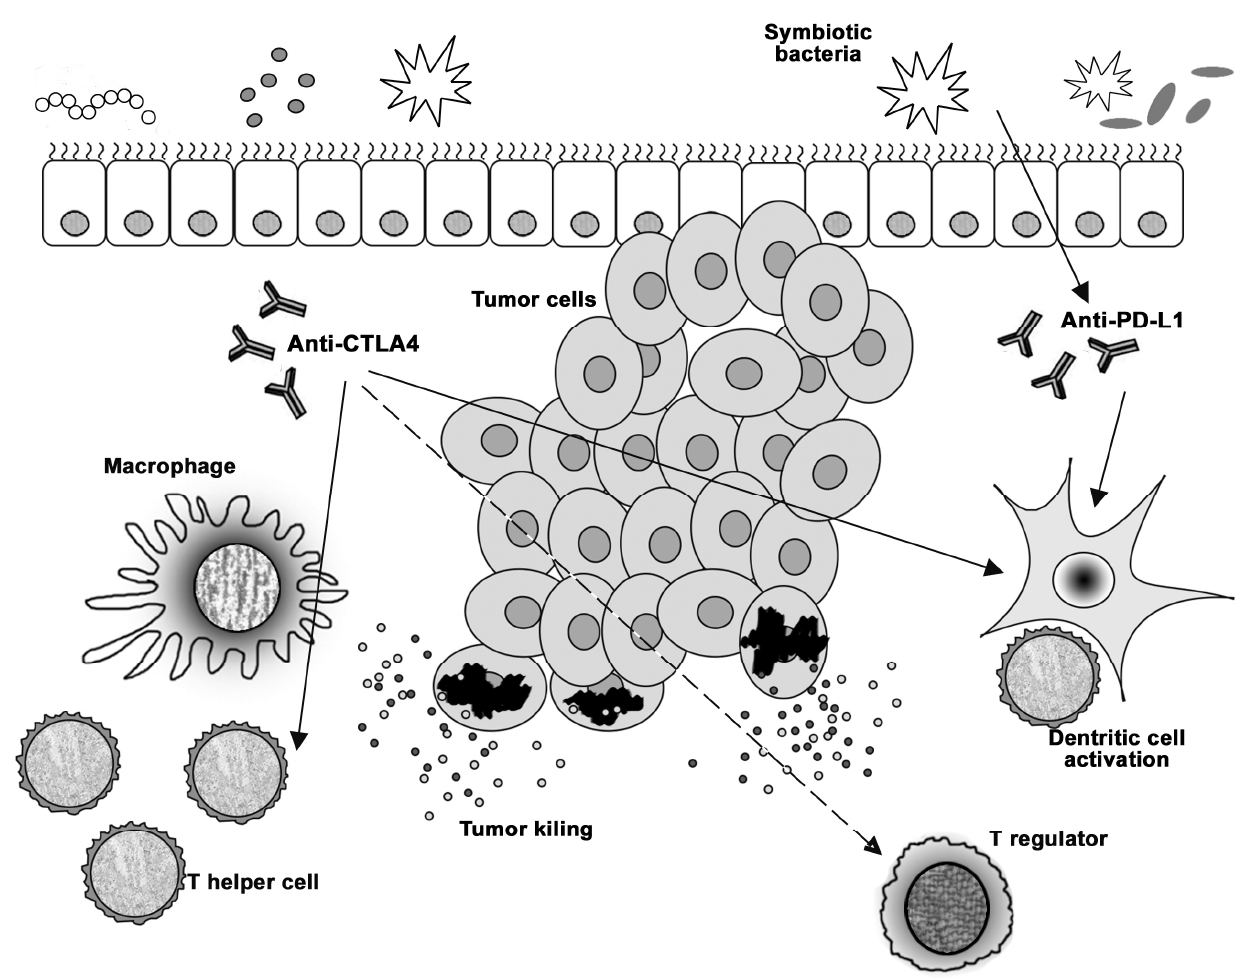
Figure 2. Immune checkpoint inhibitors interact with microbiota and immune cells to enhance anti-tumour activity. Anti-programmed death-ligand 1(PD-L1) treatments, through the interaction with symbiotic bacteria, induce the activation of dendritic cells and promote the activation and function of T-helper cells. Anti-CTLA4 enhances the activity of dendritic cells and T-helper cells while suppressing T regulatory cell function. Solid arrows indicate the activating signal, while dashed arrows indicate the inhibitory signal.